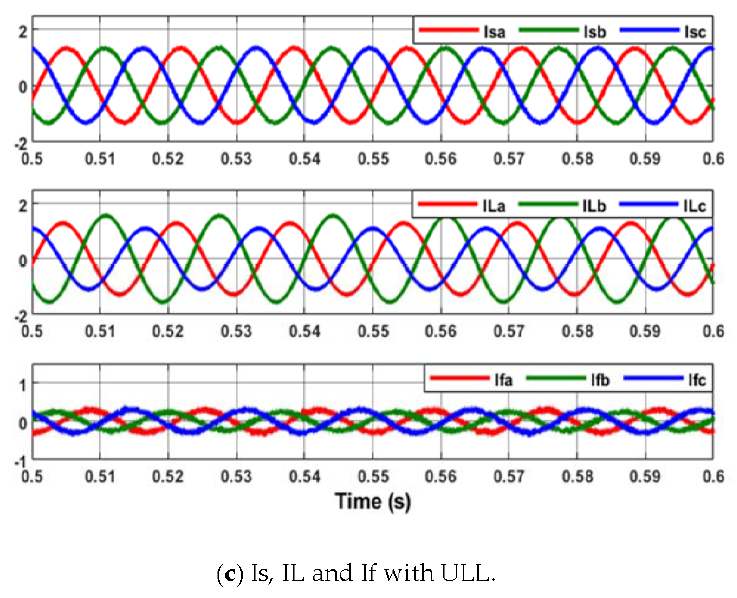
Figure 8. Is, IL and If with the shunt APF when the source voltages are unbalanced. ( a ) V PCC , I s , I L and I f with NL ( b ) I s , I L and I f with BLL. ( c ) I s , I L and I f with ULL. Table 6. Magnitudes and THD of the source currents.